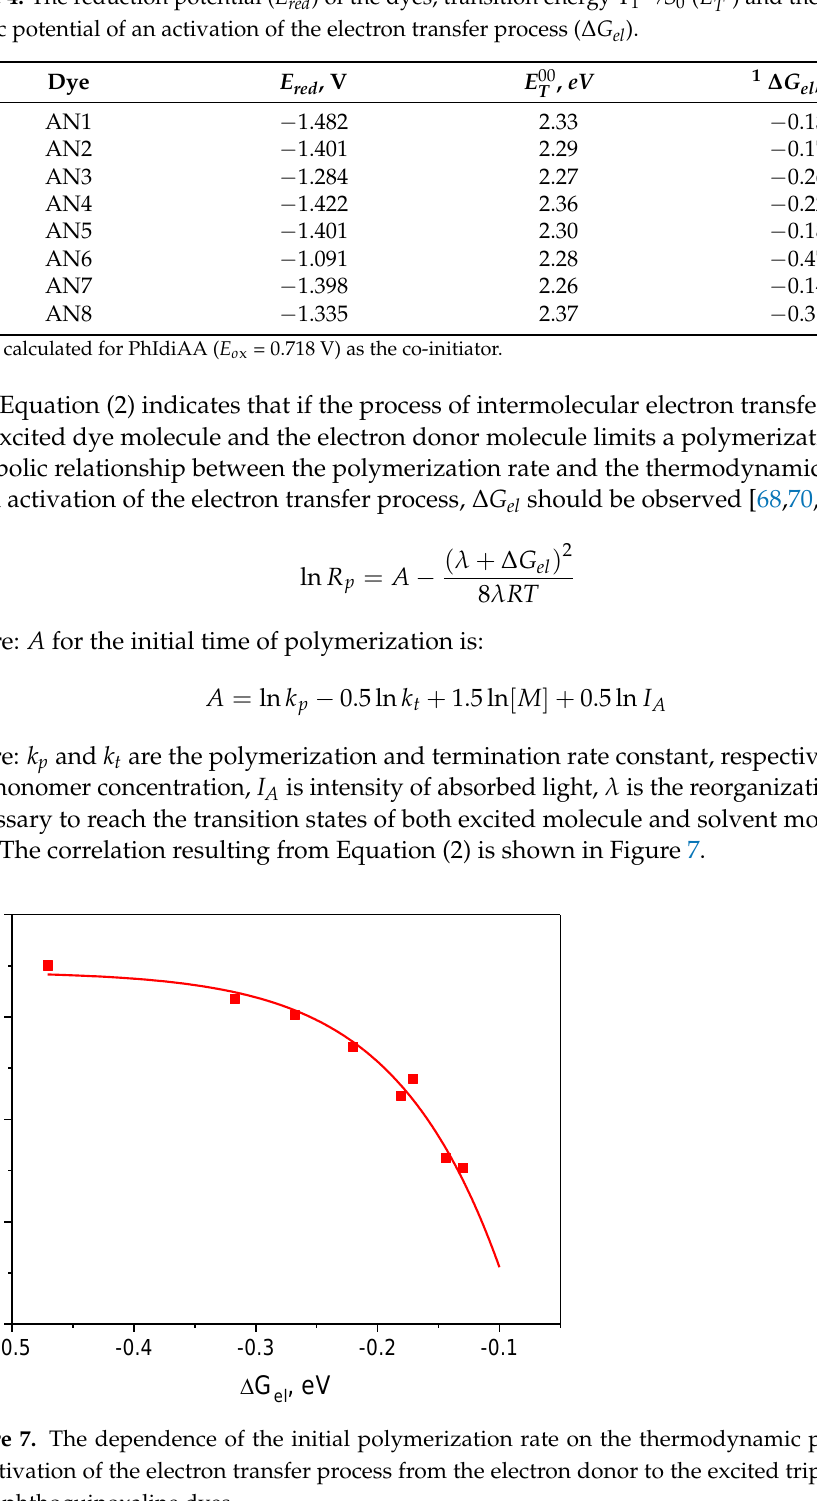
) and the thermody- T